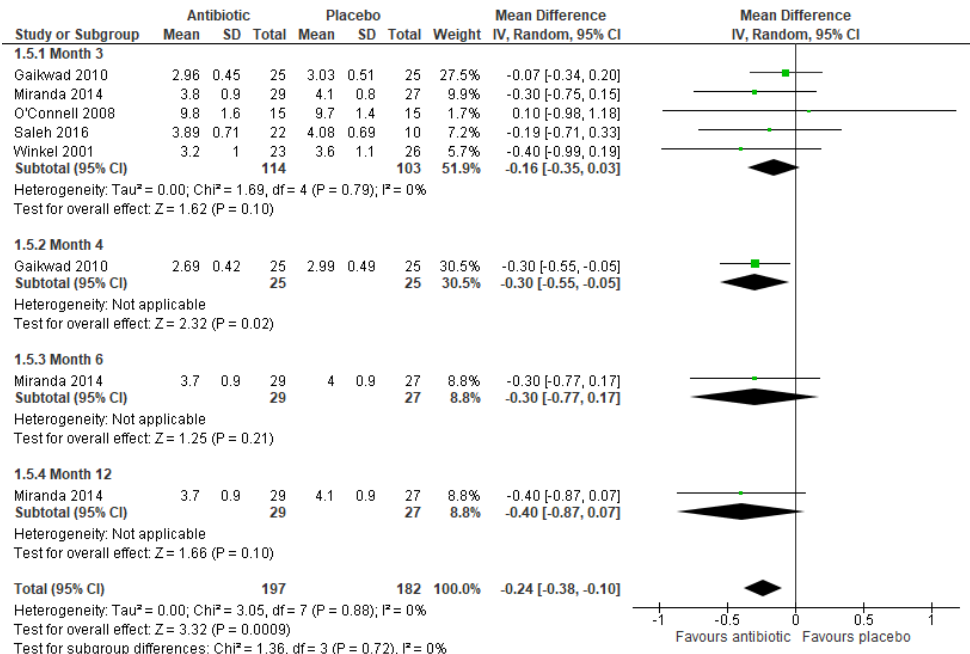
Figure 5. Meta-analysis of clinical attachment level (mm) after three months for studies assessing mechanical debridement with antibiotics in the treatment of periodontitis.